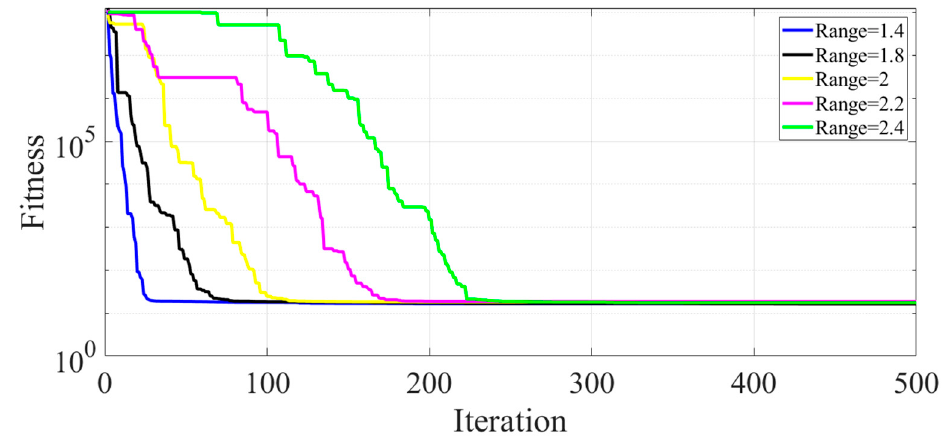
Figure 10. Diversity plot of the HMSCACSA for variants in the range of r exploration and exploitation.